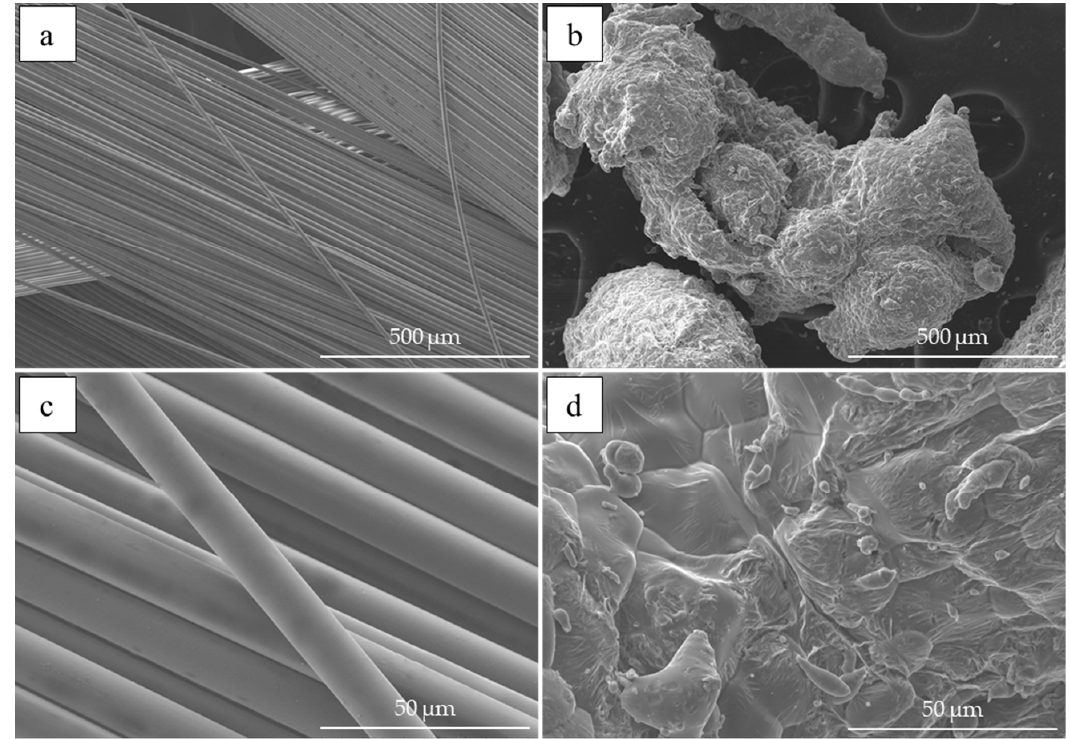
Figure 1. The microscopic images of the input materials used during research; glass fibre (on the left) and aluminium powder (on the right). Scanning electron microscope, magnification: ×100 ( a,b ), ×1000 ( c,d )—glass fibre ( a,c ) and aluminium powder ( b,d ).